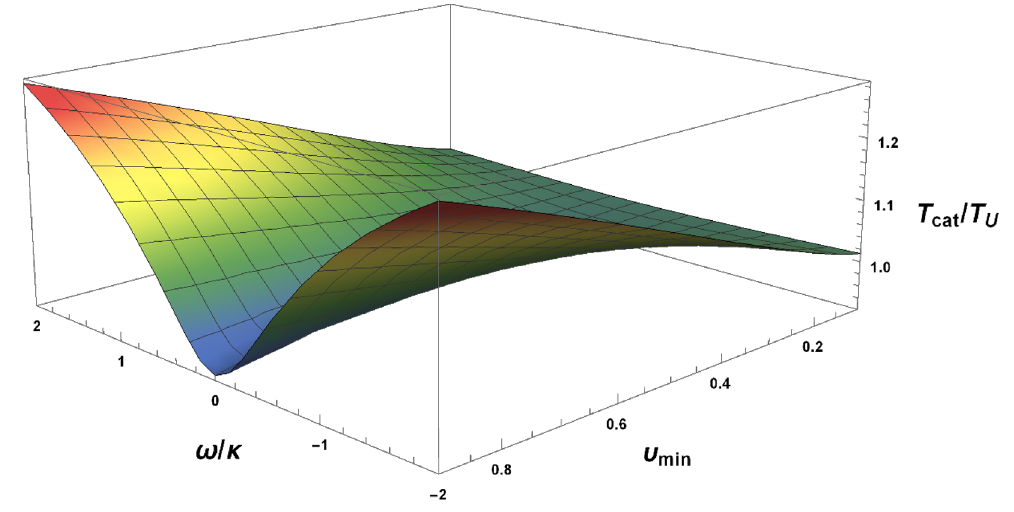
Figure 6 . The e(cid:11)ective temperature of a detector following a catenary trajectory scaled to the Unruh temperature as a function of !=(cid:20) and the minimum velocity 0 : 1 (cid:20) (cid:29) min (cid:20) 0 : 9. In the limit !=(cid:20) ! 0, a detector moving with velocity (cid:29) min = 0 : 9 reaches the coldest temperature T e(cid:11) =T U (cid:25) 0 : 92. A slowly moving detector with velocity (cid:29) = 0 : 1 reaches the Unruh temperature T e(cid:11) =T U (cid:25) 1.